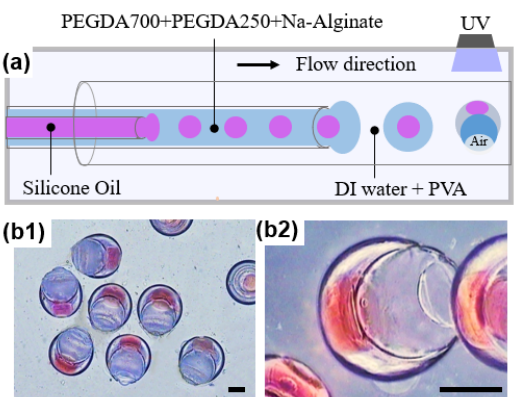
Figure 9. ( a ) Schematics of the microfluidic device used for preparing “cup-shaped” microparticles capable of encapsulating oil cores. The initial double emulsion droplets gradually formed an open hollow structure due to phase separation. ( b ) Optical microscopic images of “cup-shaped” microparticles. (b1) Optical microscopic image showing good monodispersity and uniform size and shape of microparticles; (b2) Magnified image showing the open hollow structure of the microparticle with an oil core. Silicone oil was dyed red. The scale bar is 200 µm.